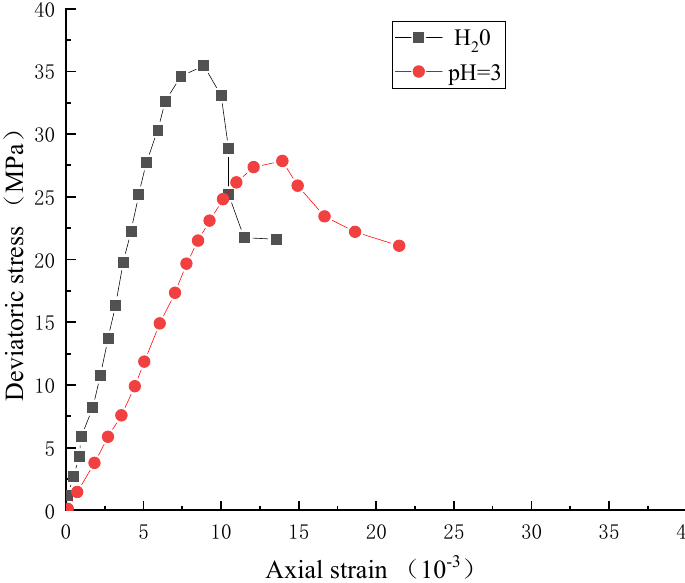
Figure 2. Experimental stress-strain curve.